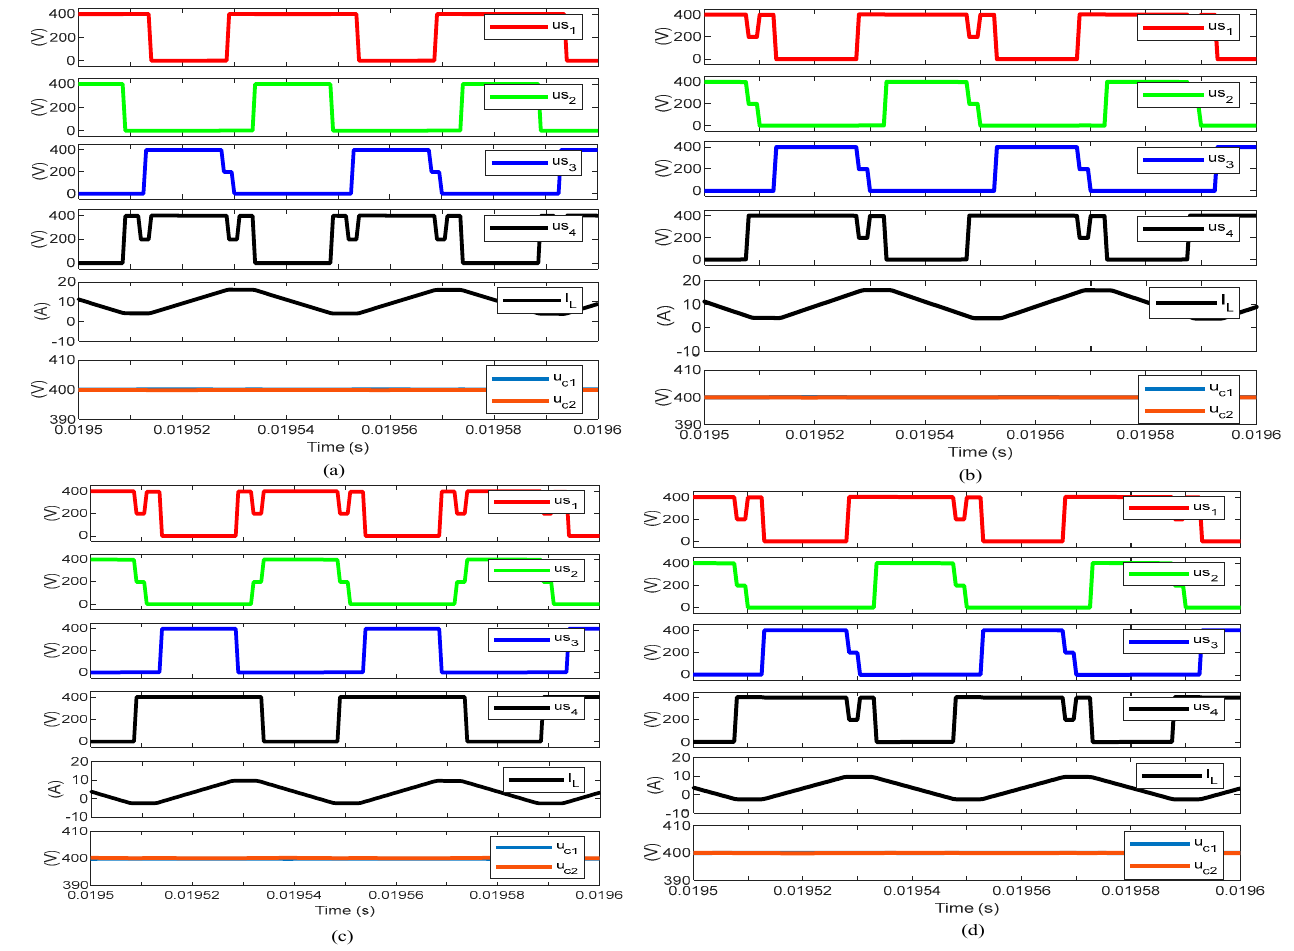
Figure 9. Switching drain-source voltages, inductor current ( I R 1 ), and output voltages. ( a ) State I. ( b ) State II. ( c ) State III. ( d ) State IV. ( b ) State II. ( c ) State III. ( d ) State